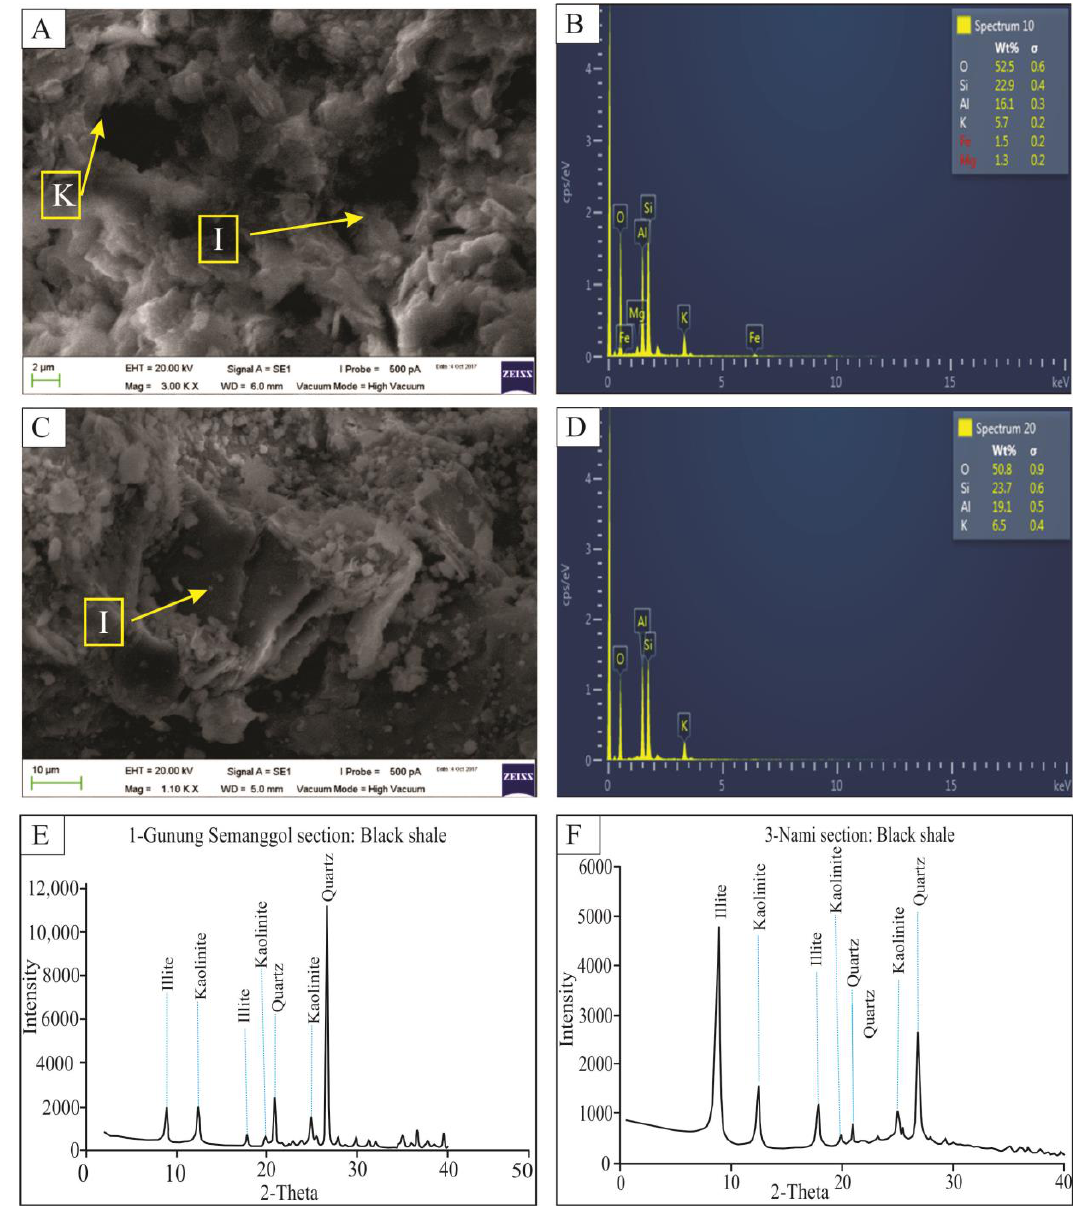
Figure 8. ( A ) SEM photo of the kaolinite in the clay fraction of the black shale from the Gunung Semanggol section; ( B ) EDX pattern of kaolinite showing Al, Si, O, Fe, and Ti peaks for the studied black shale from the Gunung Semanggol section; ( C ) SEM photo of illite in the clay fraction of the black shale from the Nami section; ( D ) EDX pattern of kaolinite displaying peaks of Al, Si, O, and K that characterize the illite composition for the black shale from the Nami section; ( E ) X-ray di ff raction pattern of the clay fraction separated from the black shale from the Gunnug Semanggol section; ( F ) X-ray di ff raction pattern of the clay fraction separated from the black shale from the Nami